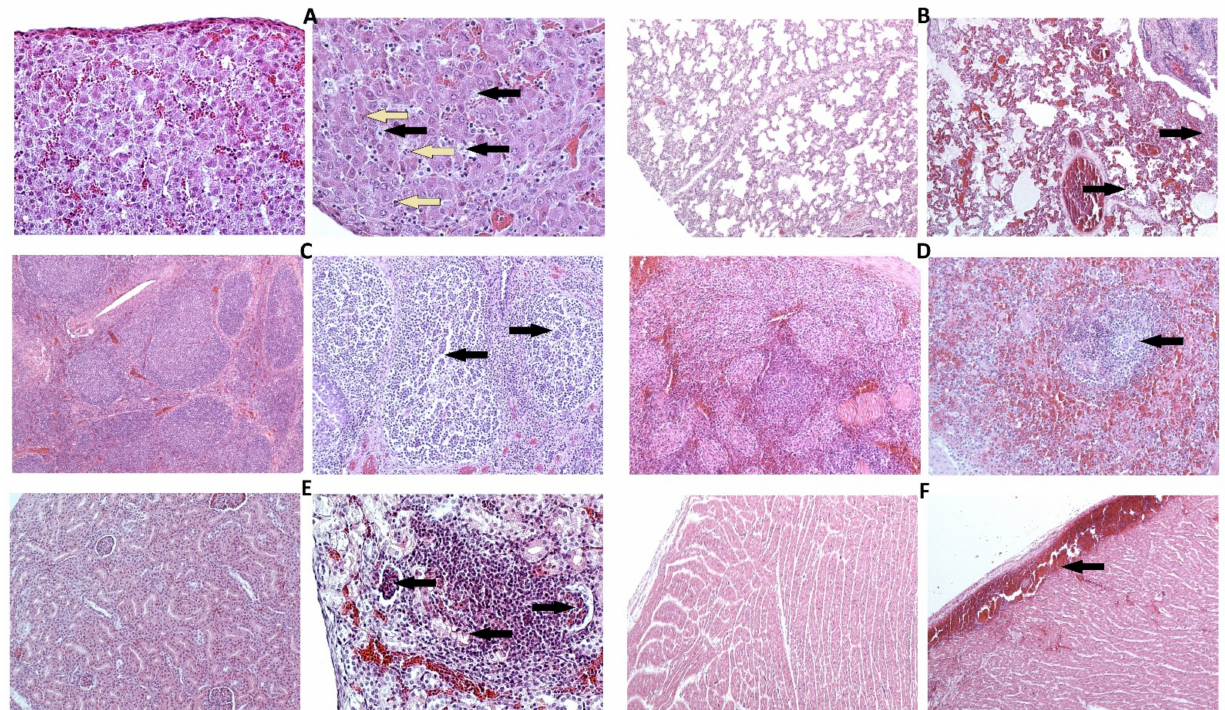
Figure 6. Selected histopathological changes observed in different organs of experimentally infect pigs ( A – F right side) compared to the Control Group ( A – F left side). ( A ) liver ( × 200), pig #21 (subacute ASF form): Moderate infiltration of hepatic sinusoids with lymphoid cells, with the presence of foamy, degenerated Kupffer cells (black arrows) and scattered necrotic hepatocytes (yellow arrows); ( B ) lung ( × 200), pig #18 (subacute ASF form): Alveolar and interstitial oedema, congested blood vessels showing moderate vasculopathy, multifocally mild interstitial, and alveolar infiltration with macrophages (arrows); ( C ) palatine tonsil (left × 100, right × 200), pig #2 (acute ASF form): Lymphoid depletion within follicles (arrows); ( D ) spleen (left × 100, right × 200), pig #19 (acute ASF form): Necrosis of lymphocytes within splenic nodule (arrow); ( E ) kidney (left × 100, right × 200), pig #20 (acute ASF form): Focal lymphocytic infiltration in the cortex, necrotic cells in tubular epithelium, and glomeruli (arrows); ( F ) heart (x100), pig #21 (subacute ASF form): Subepicardial